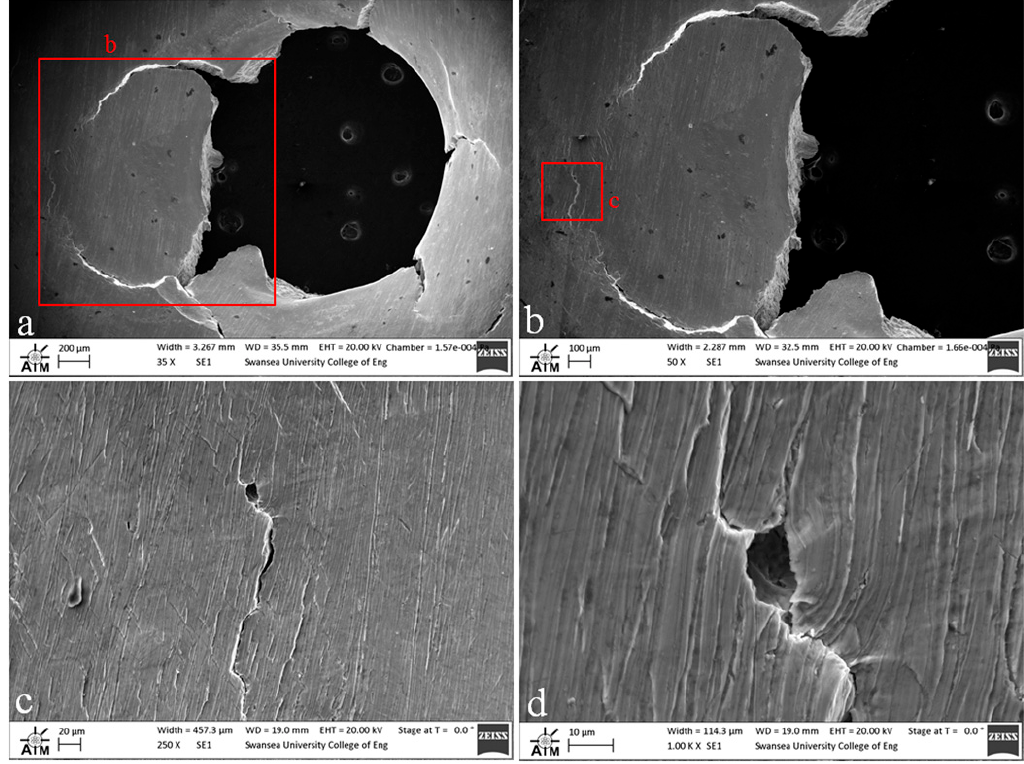
Figure 15. SEM images of the reverse side of the fractured EBM SP disc ( a ) overall fracture surface; ( b ) indication of the dominant crack path ( c , d ) typical surface breaking porosity.